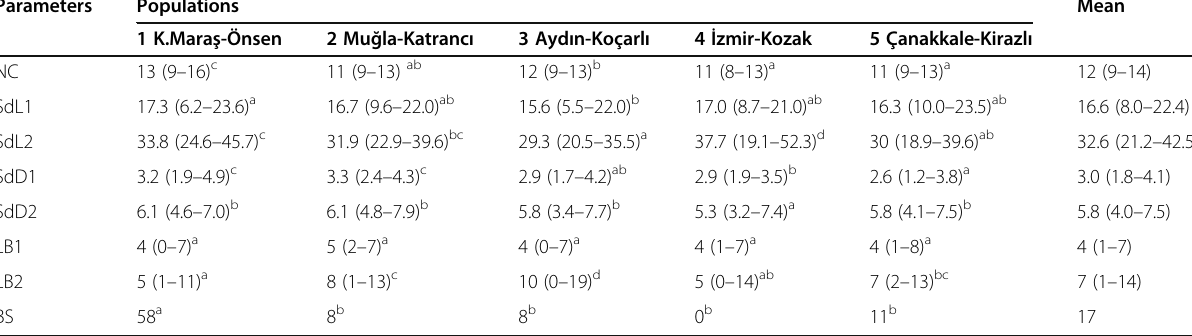
Table 5 Seedling traits of the five natural stone pine ( P . pinea ) populations in Turkey Parameters Populations